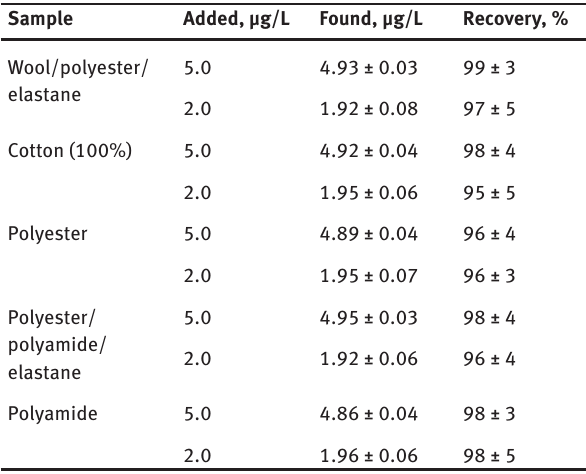
Table 5: Added/found method for Cr(VI) determination in textiles.